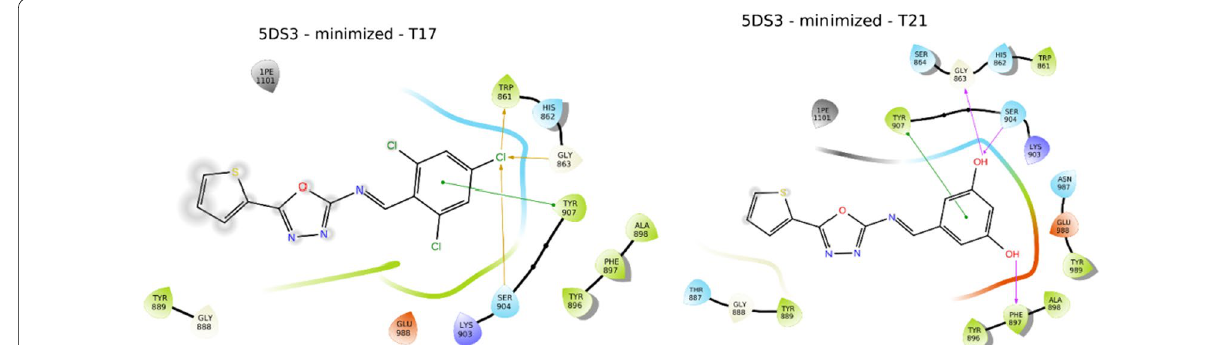
Fig. 3 Ligand interaction of compound T17 and T21 with PARP-1 5DS3